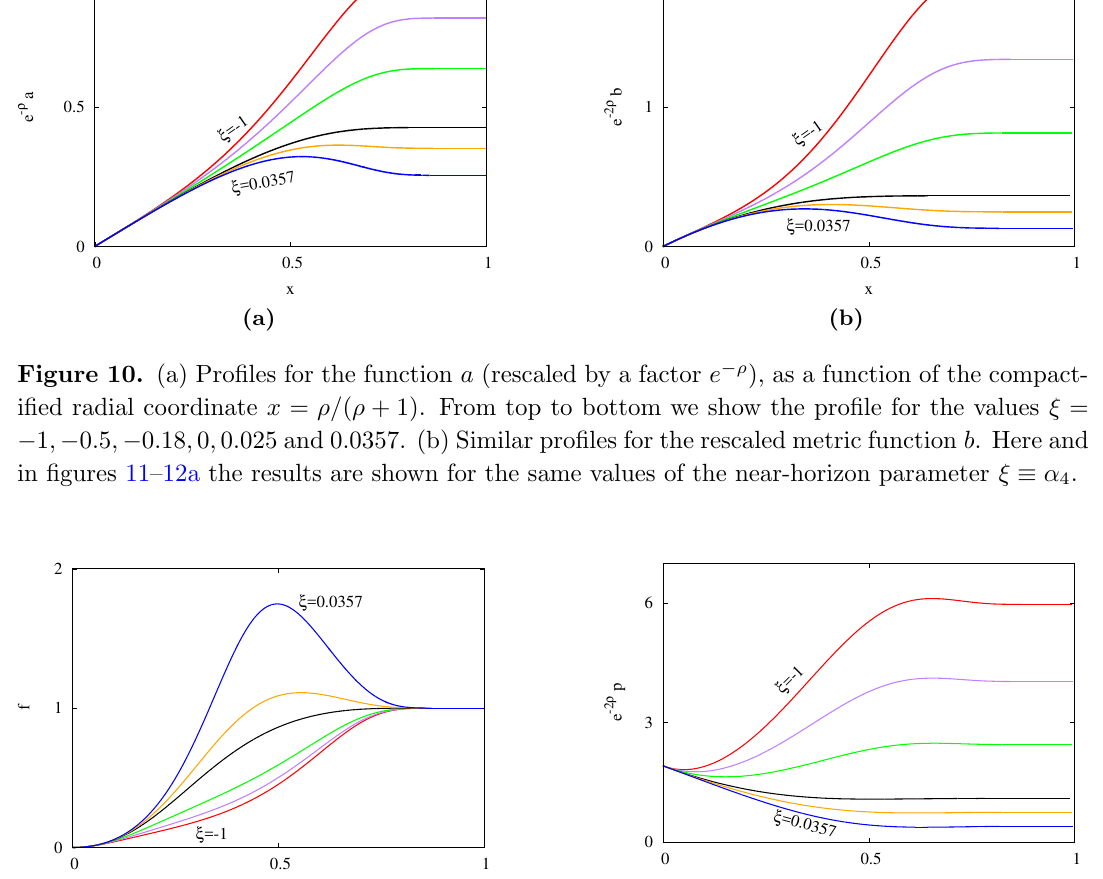
The relation of the remaining coe(cid:14)cients f a